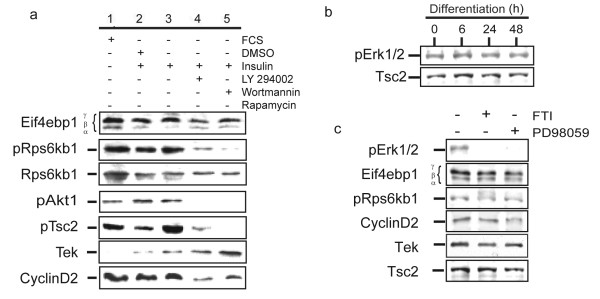
PI3K and Raf/MEK/Erk signaling in RoSH2 cells. a) Effects of PI3 K/Akt inhibitors. Undifferentiated RoSH2 cells were plated and cultured for 24 hours, then serum-starved for 20 hours before culturing in media with 50 μM LY294002 dissolved in DMSO, 100 nM wortmannin or 0.1% (v/v) DMSO for 15 min and then challenged with 100 nM insulin for 20 minutes. Cell lysates were prepared and assayed by western blot analysis; b) Raf/MEK/Erk signaling during differentiation. At 0, 6, 24 and 48 hours after plating RoSH2 cells on matrigel, cell lysates were prepared and analyzed by western blot assay for phosphorylated ERK1/2.. c) Effects of inhibiting Raf/MEK/Erk signalingRoSH2 cells were treated with 10 μM or 50 μM Ras inhibitor FTase inhibitor III, (FTI) and MEK inhibitor PD98059 for three hours and cell lysates were analyzed by western blot assays.